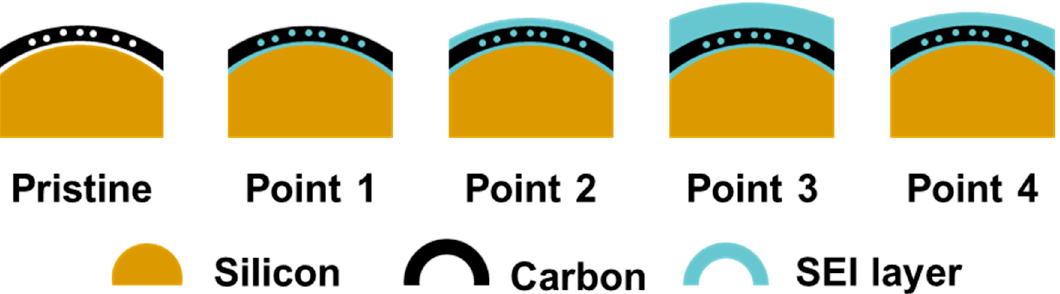
Figure 5. Schematic diagram of the pristine Si@C-network electrode and after different stages of lithiation/delithiation (points 1–4) on the Si@C-network electrode.